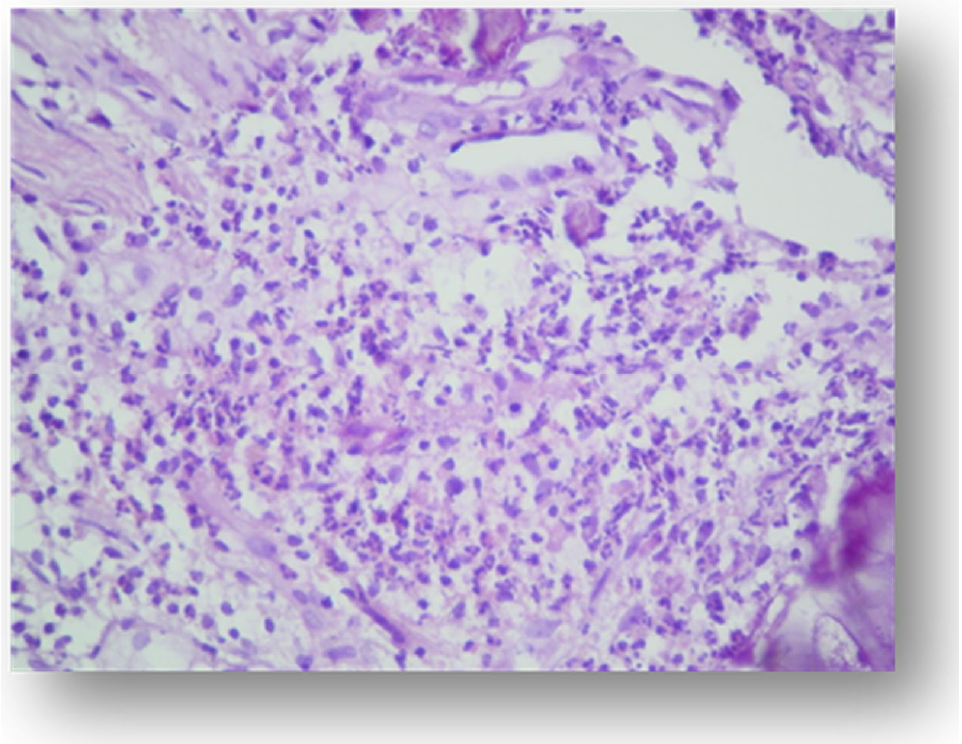
Figure 6. Dental pulp aspect (radicular section) of a 57 year old female, type 2 diabetes, HE staining, ×200.